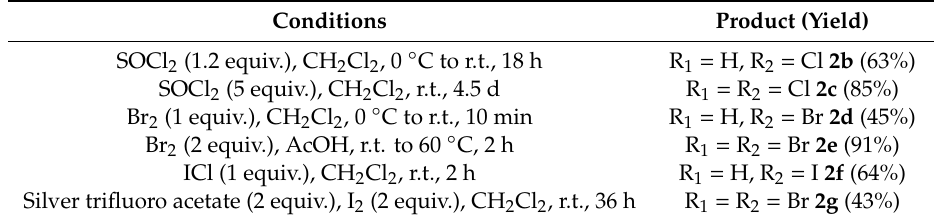
Table 1. Reaction conditions and outcomes for the synthesis of halogenated pyrroles 2b – g .